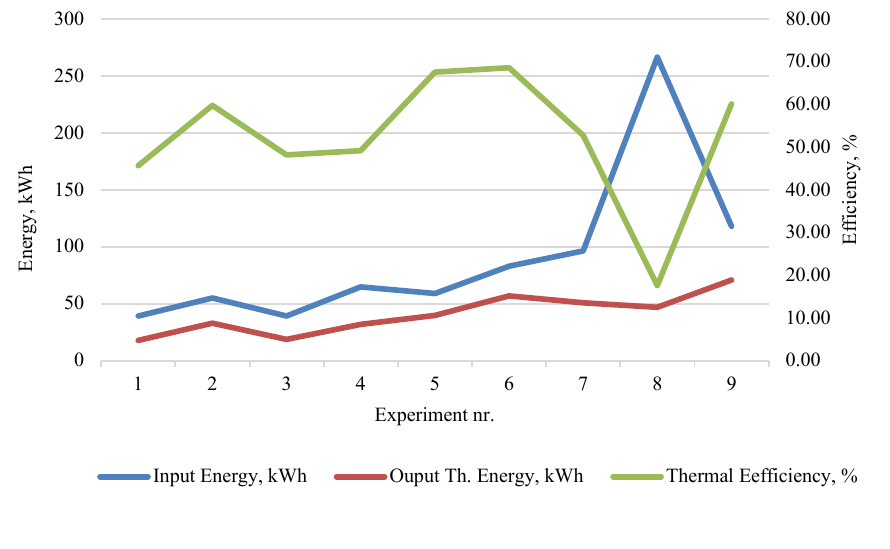
Fig. 8. Thermal efficiency of the boiler .